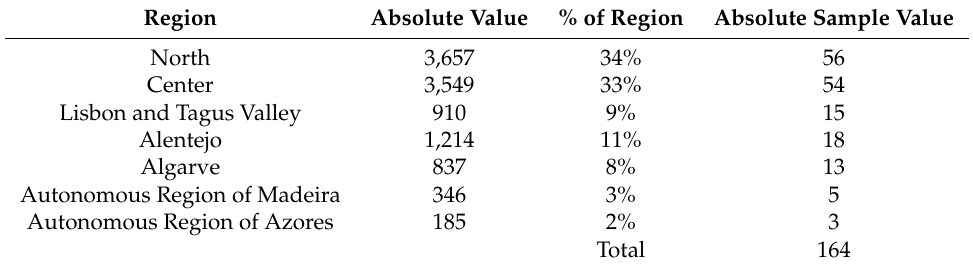
Table 2. Absolute Value of the Sample for a 99% confidence Interval and a sampling error of 10%. Region Absolute Value % of Region